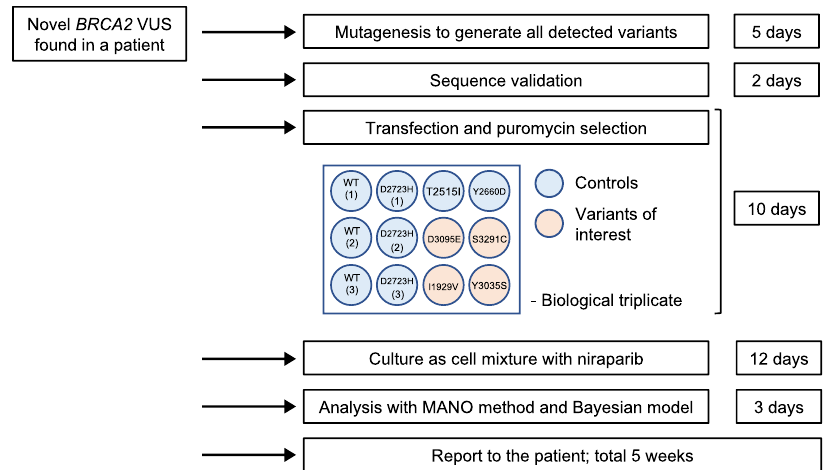
Fig. 4 The Accurate BRCA Companion Diagnostic (ABCD) test for the clinical functional annotation of novel BRCA2 VUSs. Schematic representation of the ABCD test. BRCA2 variants were investigated by genomic DNA sequencing. The effect of variants on mRNA splicing was evaluated by RNA sequencing to detect the aberrant BRCA2 transcripts. All detected cDNAs, including four control variants for functionally normal (wild-type and T2515I) and abnormal (Y2660D and D2723H) variants and four variants of interest, were generated for assessment by the small-scale MANO-B method in a 12-well plate. Technical and biological triplicate experiments using niraparib at 0.5 μ M are recommended. Data analysis was performed with data from previous experiments, enabling batch effect adjustment. The experimental steps and required times are